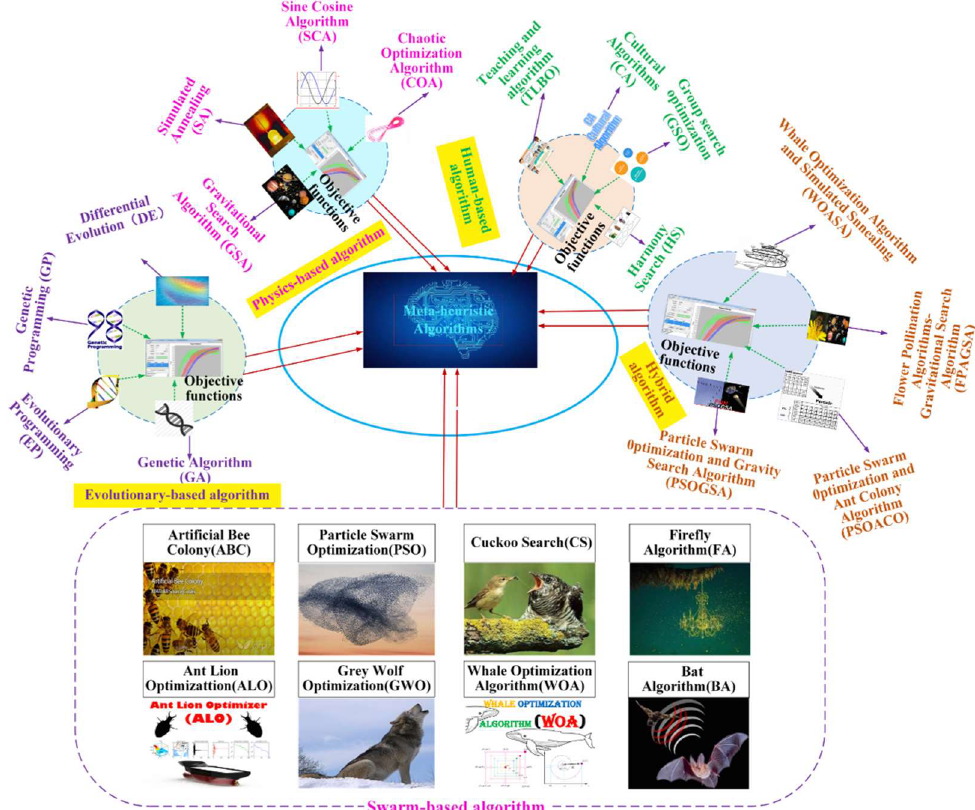
Figure 3. The main categories of meta-heuristic algorithms.